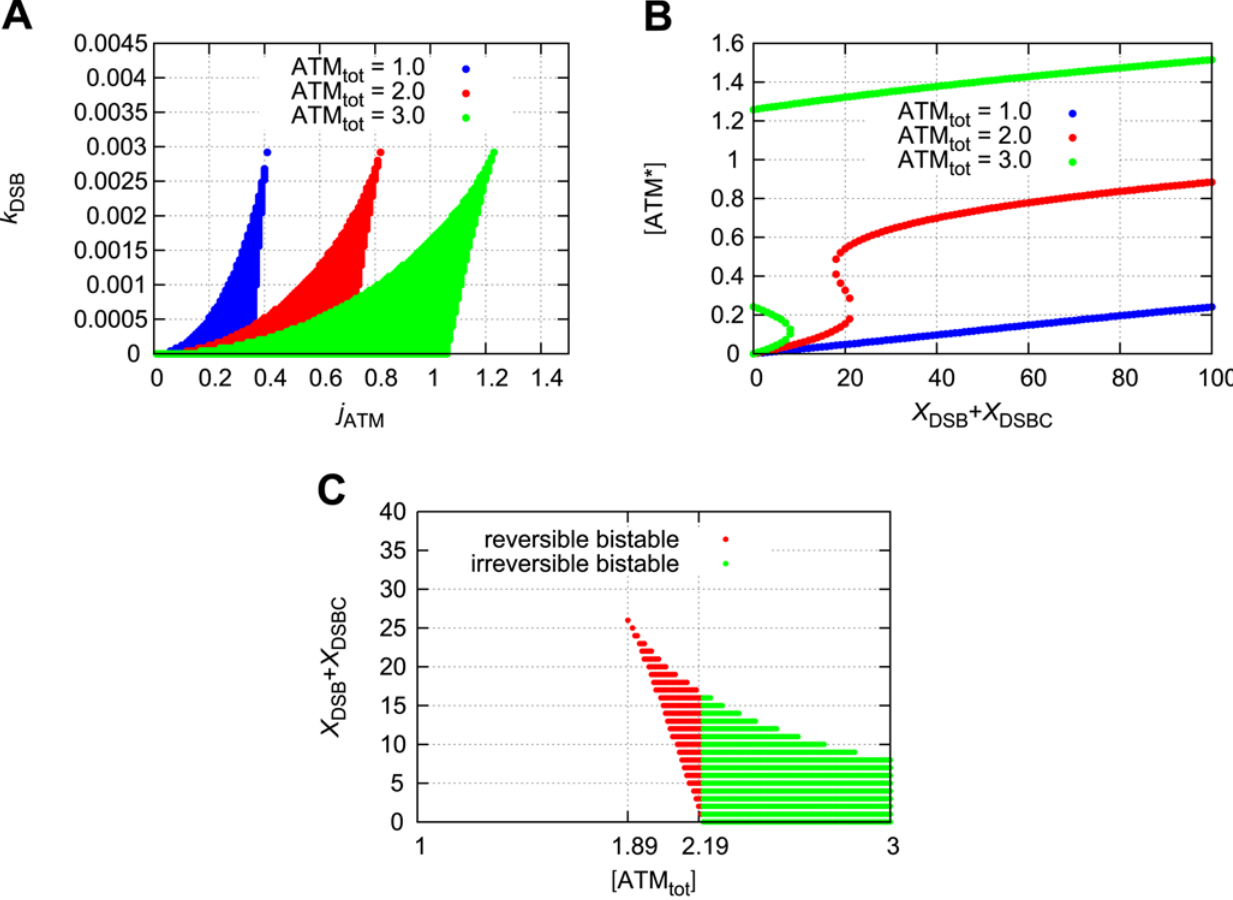
Figure 6. Bistability emerges as the total concentration of ATM increases. (A) Bistable regions for the rate constants k DSB and j ATM with several total concentrations of ATM. The numbers of DSBs and DSBCs are constant X DSB z X DSBC ~ 20 . (B) The fixed points of [ATM*] as a function of X DSB z X DSBC with k DSB ~ 0 : 0023 and j ATM ~ 0 : 78 . (C) Bistable regions for X DSB z X DSBC and ATM tot ½ (cid:1) . The red points denote reversible bistability and the green points denote irreversible bistability.